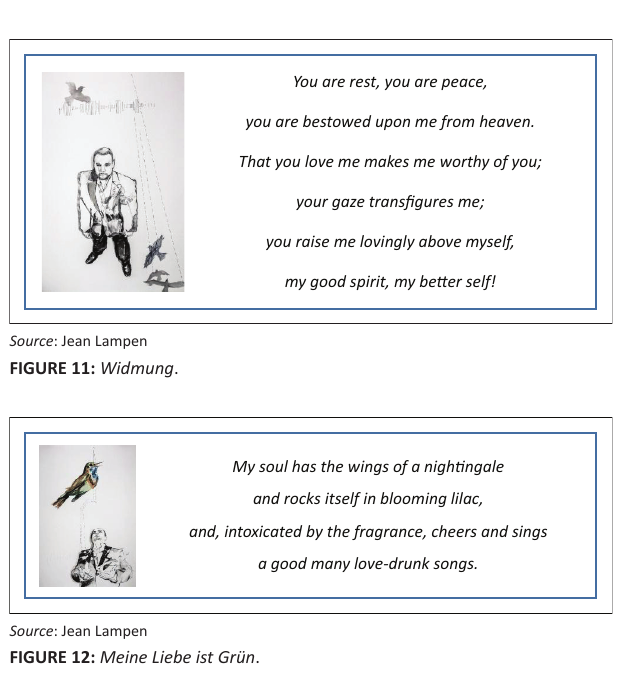
FIGURE 12: Meine Liebe ist Grün